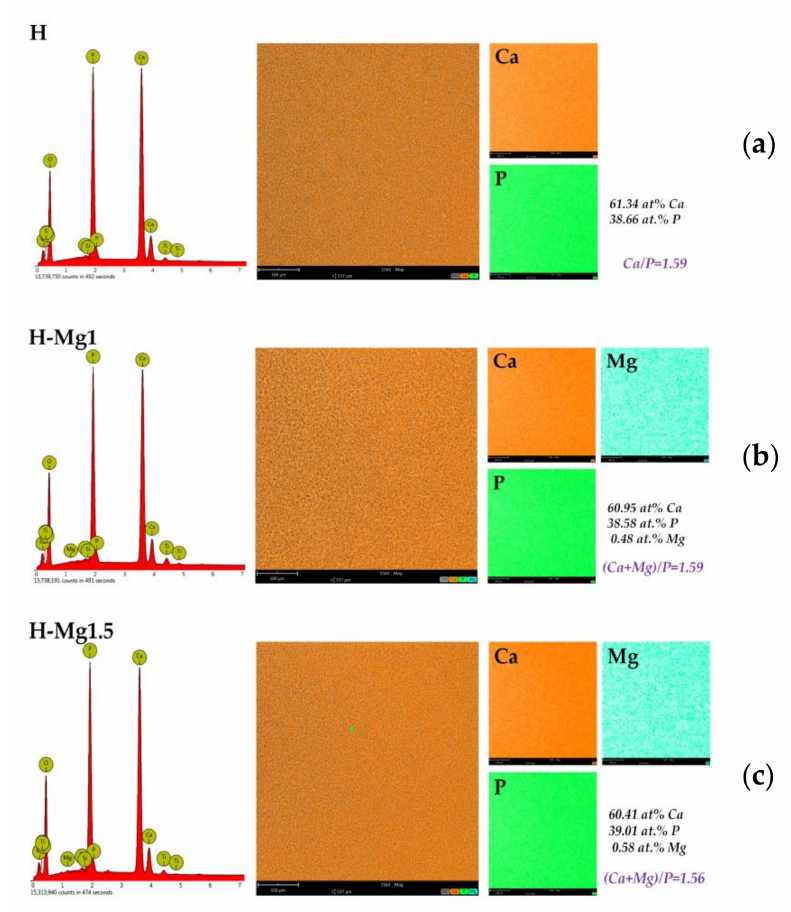
Figure 3. X-ray energy dispersive spectroscopy (EDS), elemental distribution, and chemical composition of the undoped ( a ) and Mg-doped hydroxyapatite (Hap) ( b , c ) based